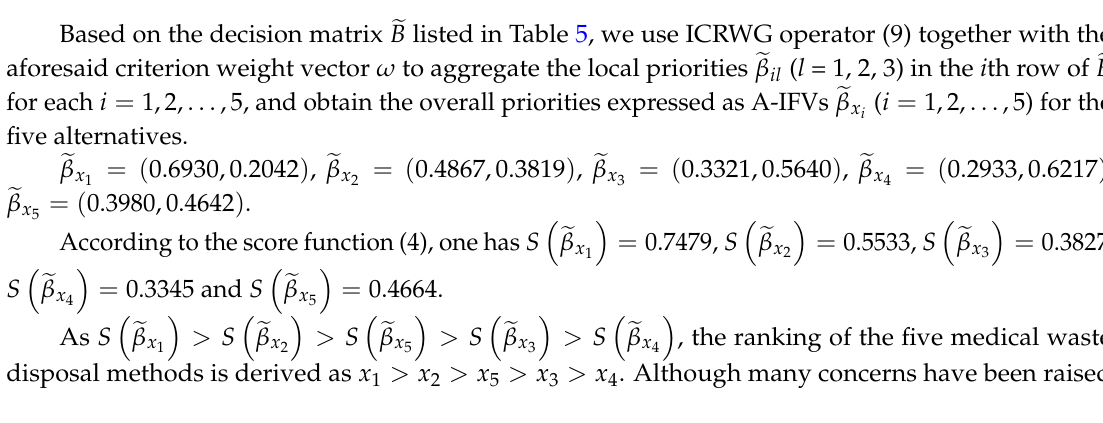
Table 5. Decision matrix (cid:101) B = ( (cid:101) β il )